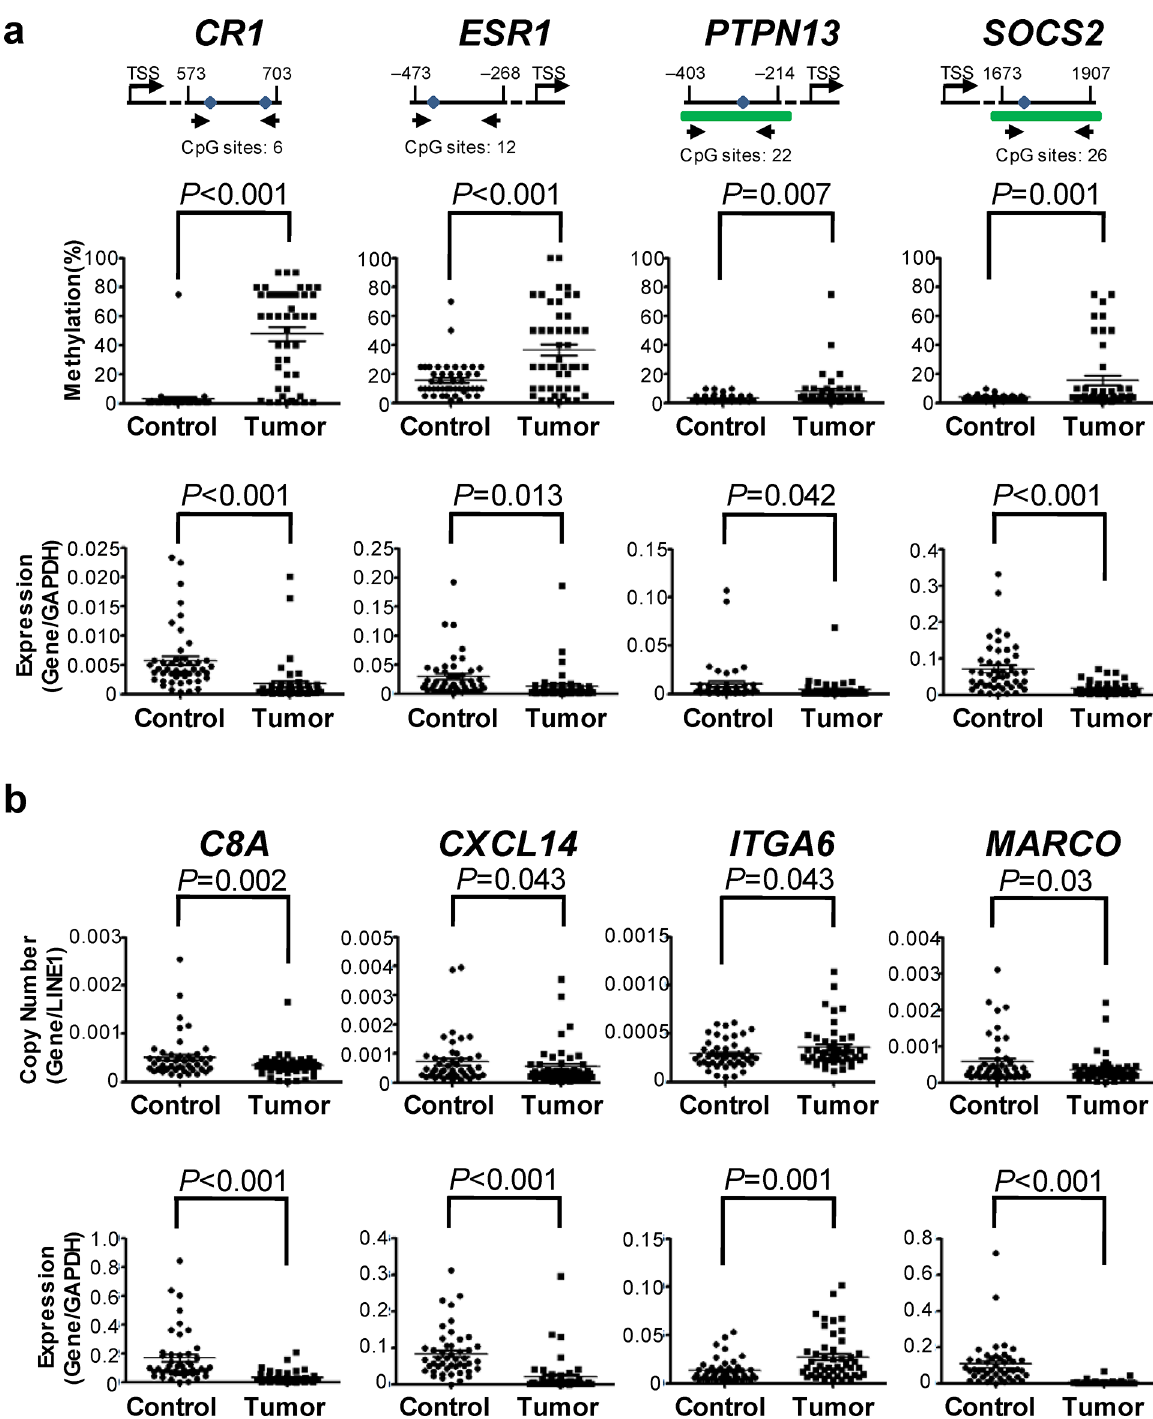
Fig 4. Validation of mRNA expression, DNA methylation and copy number variation of the randomly selected inflammation-related genes in 47 samples. (a) Validations of mRNA expression and DNA methylation of CR1 , ESR1 , PTPN13 and SOCS2 . TSS , transcription start site; Tumor, HCCs; Control, paired non-tumor tissues. Arrows represent the validation primers. Blue dots represent the significant methylation probes designed in array. Green bars represent the CpG island. (b) Validation of gene expression and copy number variation of C8A , CXCL14 , ITGA6 and MARCO .